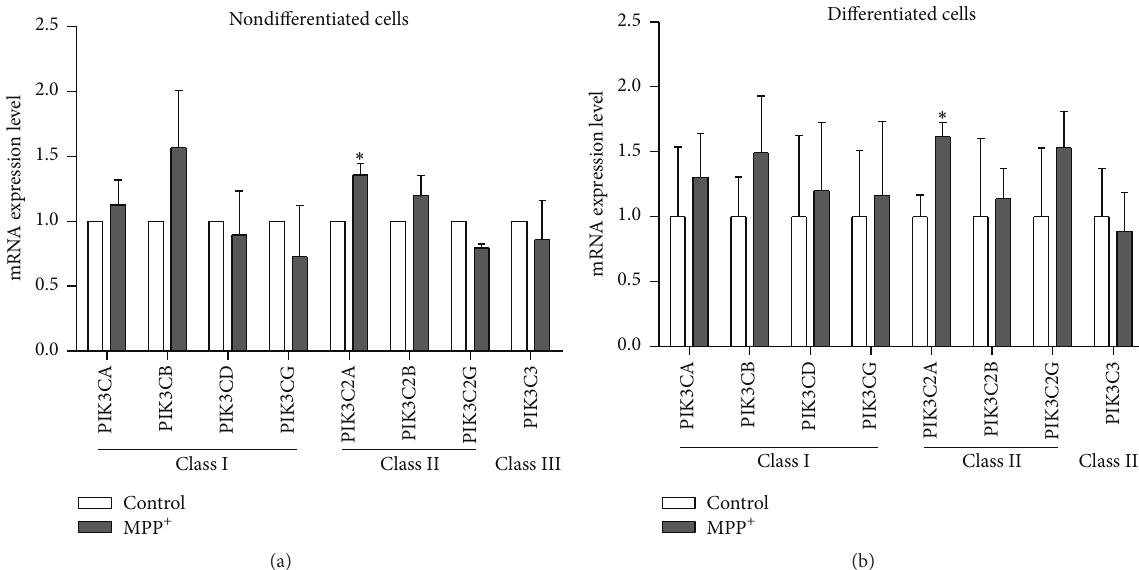
Figure 9: mRNA expression levels of genes of PI3K classes I, II, and III in nondifferentiated SH-SY5Y cells (a) and mRNA expression levels of genes of PI3K classes I, II, and III in differentiated SH-SY5Y cells (b). For neuronal differentiation, SH-SY5Y cells were treated with 10 𝜇 M retinoic acid for three days before exposure to MPP + . The control groups for nondifferentiated and differentiated SH-SY5Y cells were treated with the same medium without MPP + . Real-time quantitative PCRs were repeated three times in triplicate measurement. Data are expressed as relative to a control and shown as mean ± SEM. ∗ indicates 𝑃 < 0.05 versus control of each